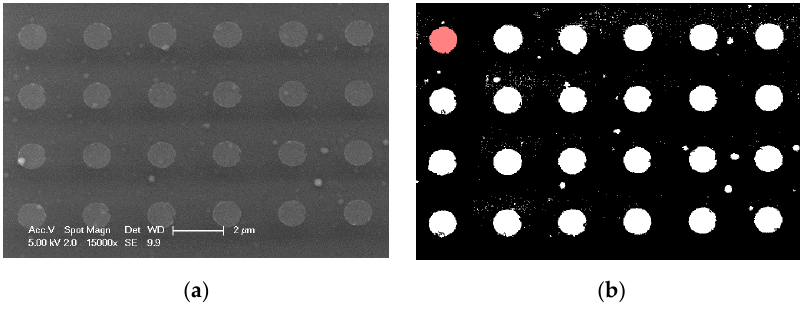
Figure 5. ( a ) Scanning electron micrograph of sample area and ( b ) binarized image